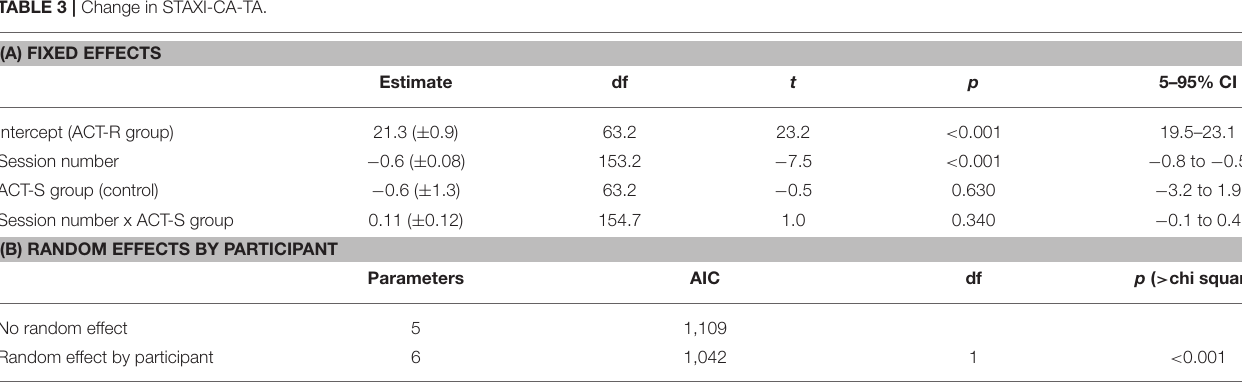
TABLE 3 | Change in STAXI-CA-TA.